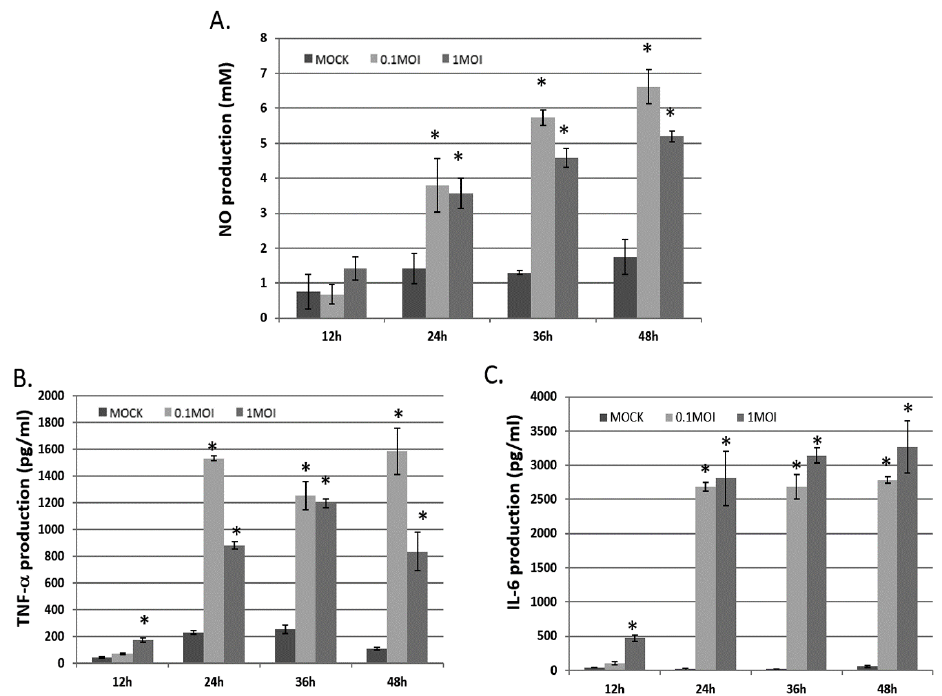
Figure 1. Levels of NO, IL-6 and TNF- α in a mouse brain, either without or with indicated doses of PRV infection. NO, IL-6 and TNF- α production as observed in MOCK (not infected) or infected BV-